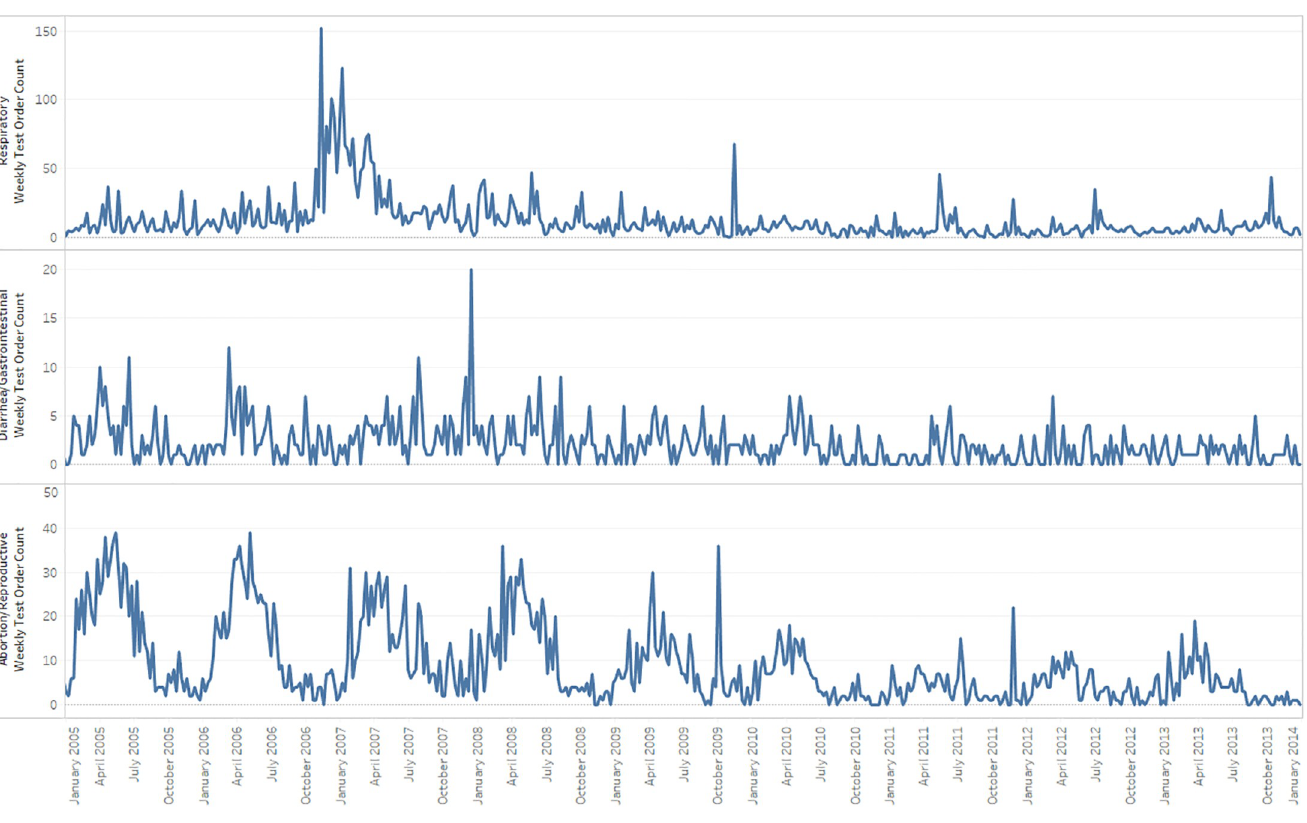
Fig 3. Time series plots of weekly counts of Abortion/Reproductive, Diarrhea/GI, and respiratory syndromes.